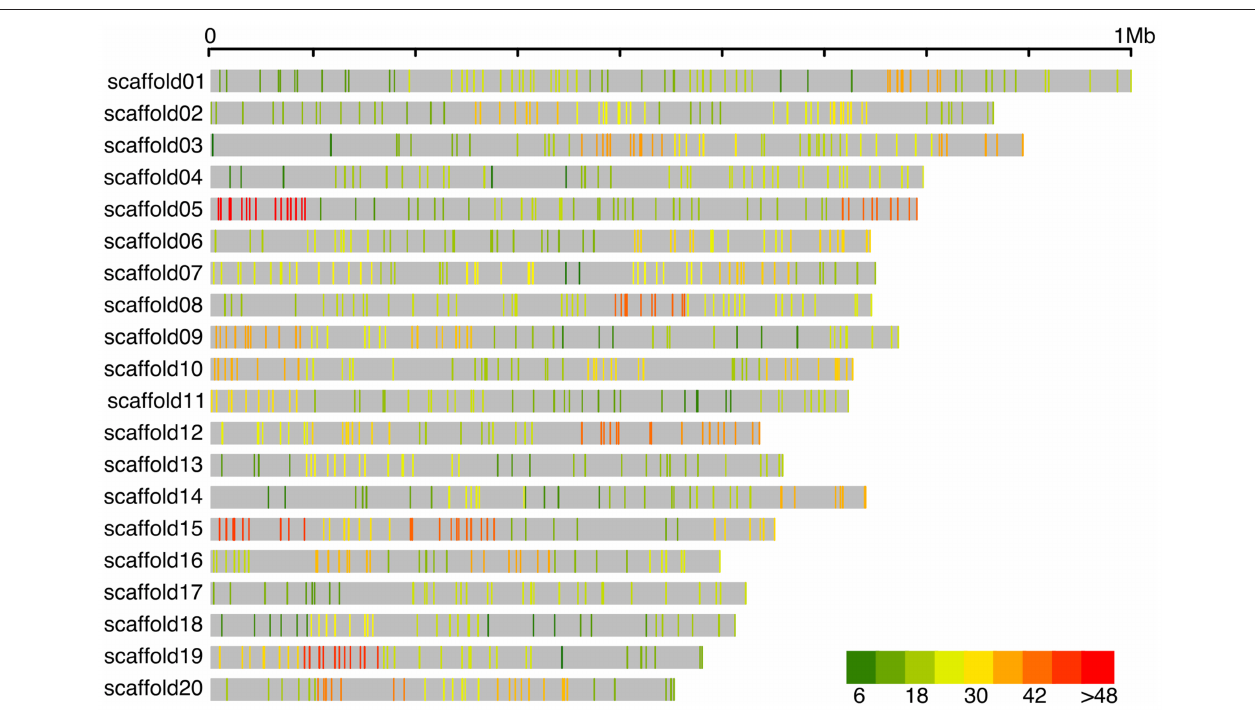
FIGURE 2 | Distribution of filtered SNPs from the tetraploid pipeline in 100kb windows across the 20 largest blueberry scaffolds (gray). The x-axis represents the distance in base pairs.